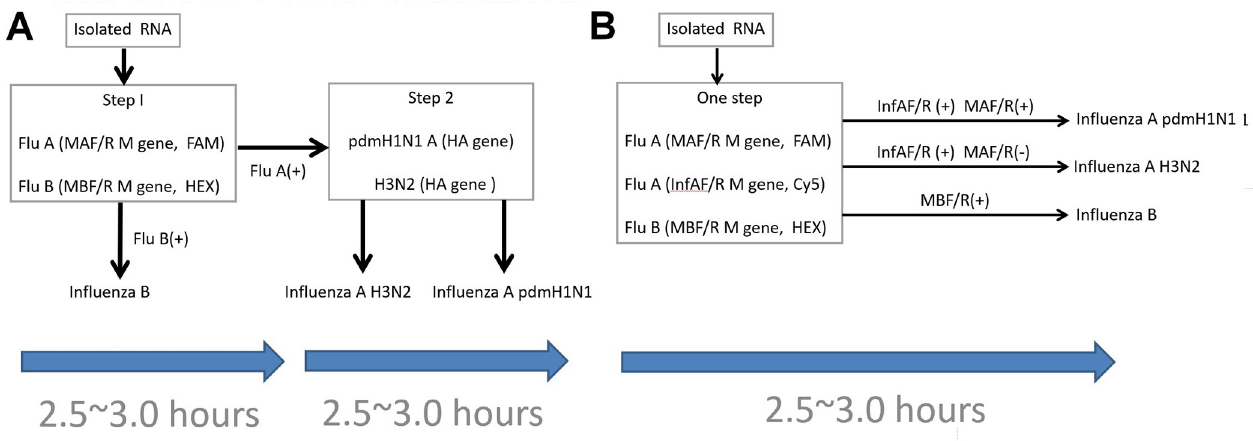
Fig 1. Real-time multiplex RT-PCR and conventional singleplex RT-PCR assays for the detection of Influenza B, Influenza A pdm H1N1, and Influenza A H3N2 viruses. A. Conventional two-step procedure with two separate assays for detection. B. One-step detection procedure using the multiplex RT-PCR assay developed in this study. The primers and probes used for detection are indicated. Flu, influenza; RNA, ribonucleic acid; MA, InfA and MB, three types of primers; F/R, forward/reverse, (+) and (-), positive and negative, respectively; HA, hemagglutinin gene; FAM, HEX, and Cy5, different Taqman probes for the